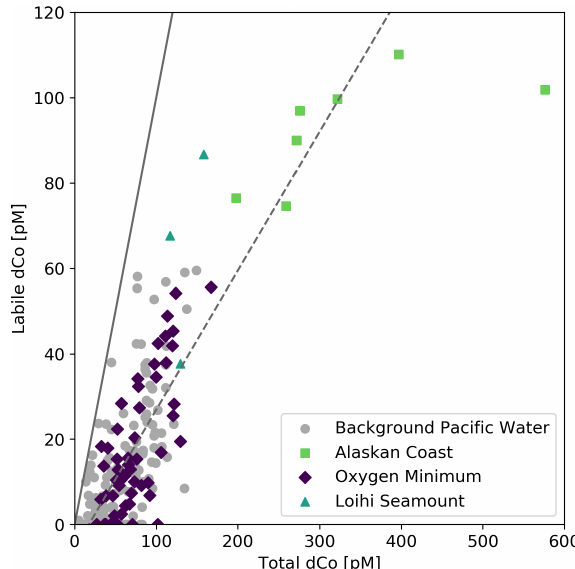
Figure 7. Labile dCo vs. total dCo, with notable sources of dCo plotted in color, including Station 1 along the Alaskan coast (green squares), oxygen minimum zones where O 2 concentrations are less than 50µmolkg − 1 (purple diamonds) and samples from within the Loihi Seamount vent plume (teal triangles). A theoretical 1 : 1 line (solid) and a linear regression of background Pacific seawa- ter (dashed; slope = 0.33 ± 0.02, R 2 = 0.55, n = 237) are shown. Points to the right of the trend line represent greater dCo complexa- tion compared to background seawater, and points to the left of the trend line represent more labile, un-complexed Co pools compared to background